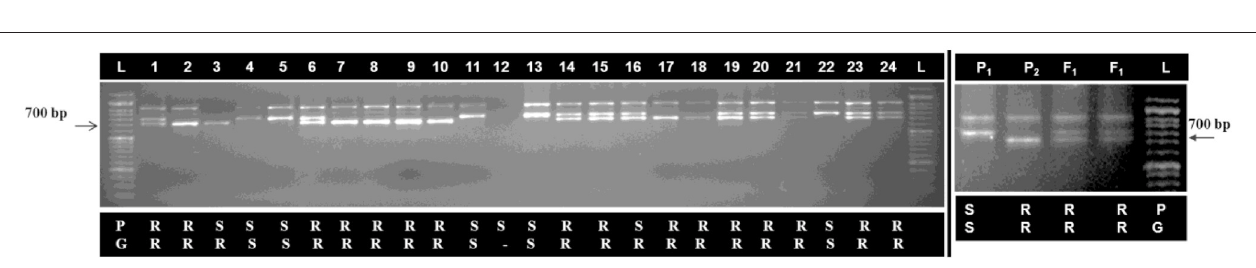
FIGURE 7 | Genotyping of inter-specific BC 1 population for black rot resistance using linked marker (ILPAt1g70610). (Resistance specific band ∼ 700 bp), (1–24, BC 1 plant number), P 1 , Pusa Sharad and P 2 , NPC-9, F 1 ; Interspecific hybrid of “Pusa Sharad × NPC-9” P = phenotype for black rot disease, G = genotype for linked marker, R = resistant, S = susceptible and L; 1Kb DNA ladder. (Two gel pictures were grouped together and separated using black vertical